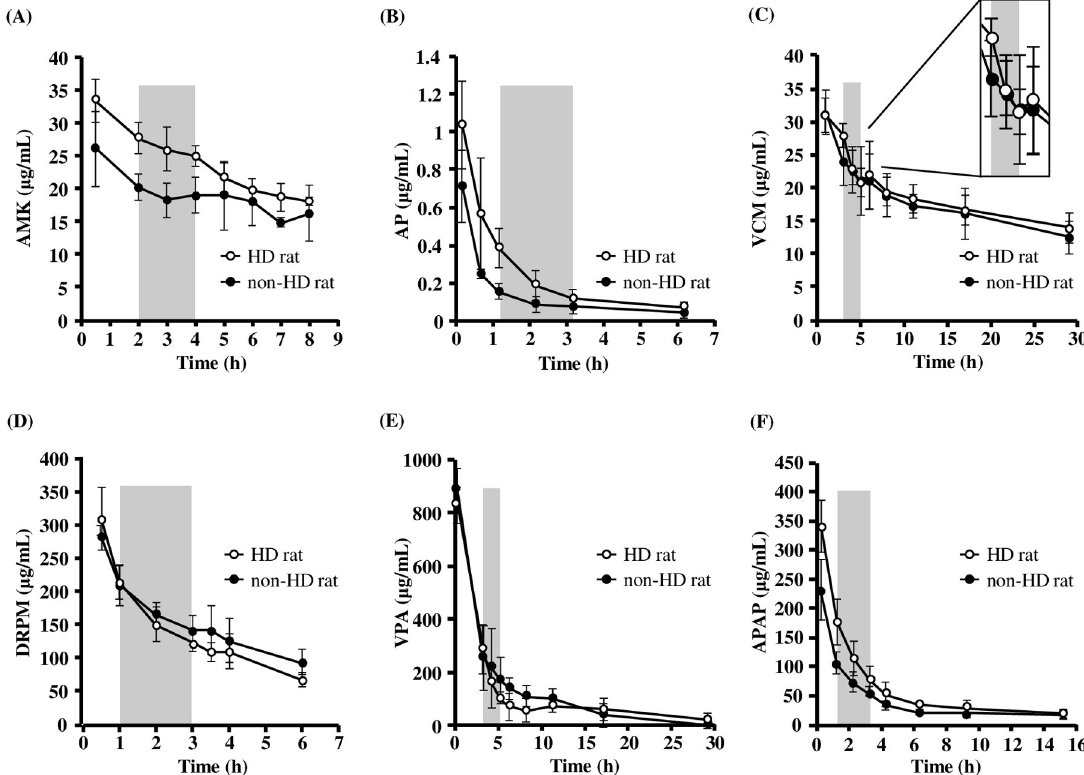
Fig 3. Plasma concentration-time curve of drugs by HD. The blood of each HD rat was corrected and concentration of drugs [AMK (A), AP (B), VCM (C), DRPM (D), VPA (E) and APAP (F)] was measured. Hemodialysis timing was represented by the gray area. � : HD rat ( n = 4–7), ● :non-HD rat ( n = 3–4). Values are expressed as the mean ± SD. AMK: amikacin sulfate, AP: aprindine hydrochloride, VCM: vancomycin hydrochloride, DRPM: doripenem hydrate,VPA: sodium 2-propylvalerate (valproic acid sodium), APAP: acetaminophen.